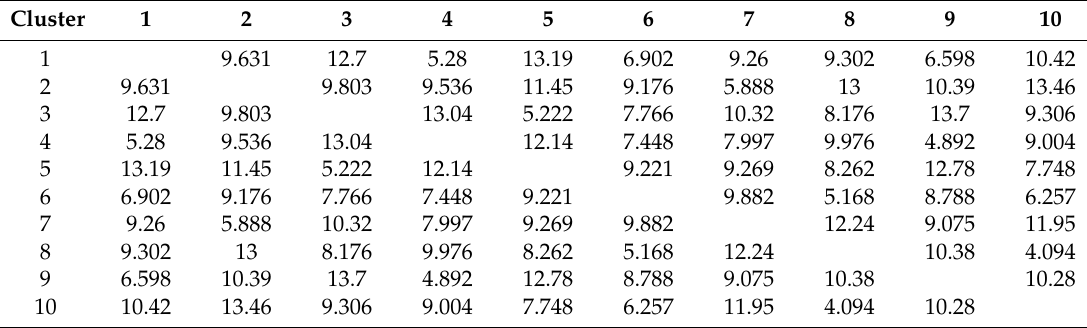
Table 4. Nearest clusters analysis showing Mahalanobis D 2 distance between groups of USDA Amaranths